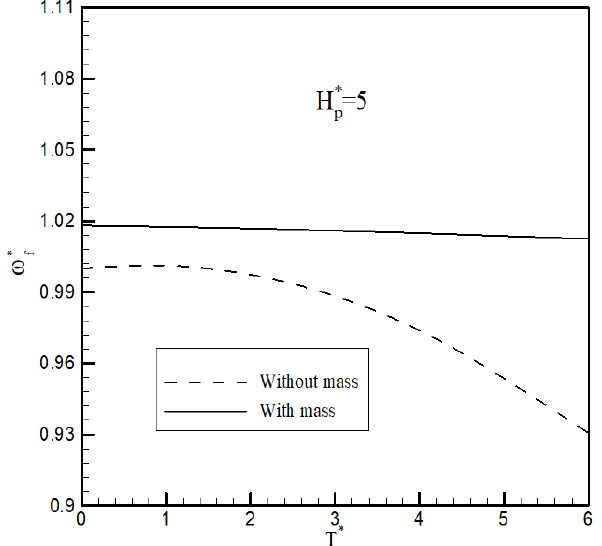
Figure 9. The effect of the tip propulsor thrust, angular momentum, and mass on the flutter frequency of the wing (case